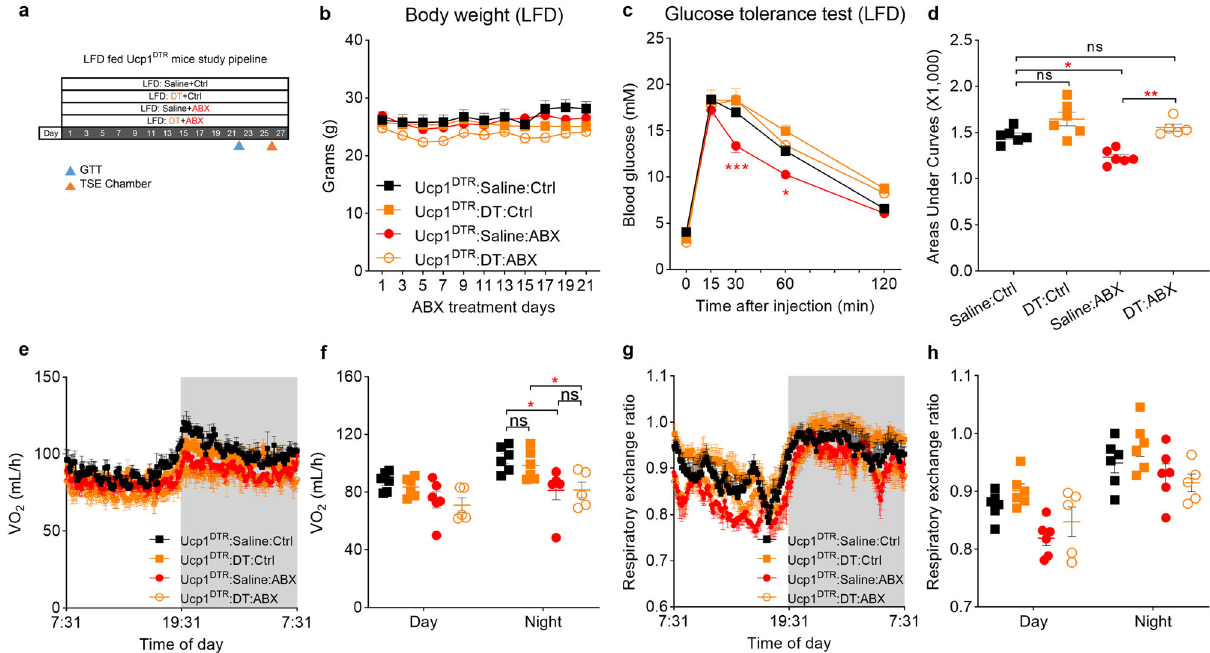
Fig. 4 Deletion of Ucp1 + cells in lean mice blocked the gut microbiota depletion-modulated glucose clearance improvement. a Experimental scheme. 10-weeks low fat diet (LFD)-fed Ucp1 DTR mice were divided into four groups. Saline-Ctrl group (black square) received subcutaneous saline injections and drank autoclaved water; DT-Ctrl group (orange square) given subcutaneous DT injection and drank autoclaved water; Saline-ABX group (red circle) received saline injections and ABX treatment; and DT-ABX group (orange open circle) given subcutaneous DT injection and ABX treatment (Ucp1 DTR